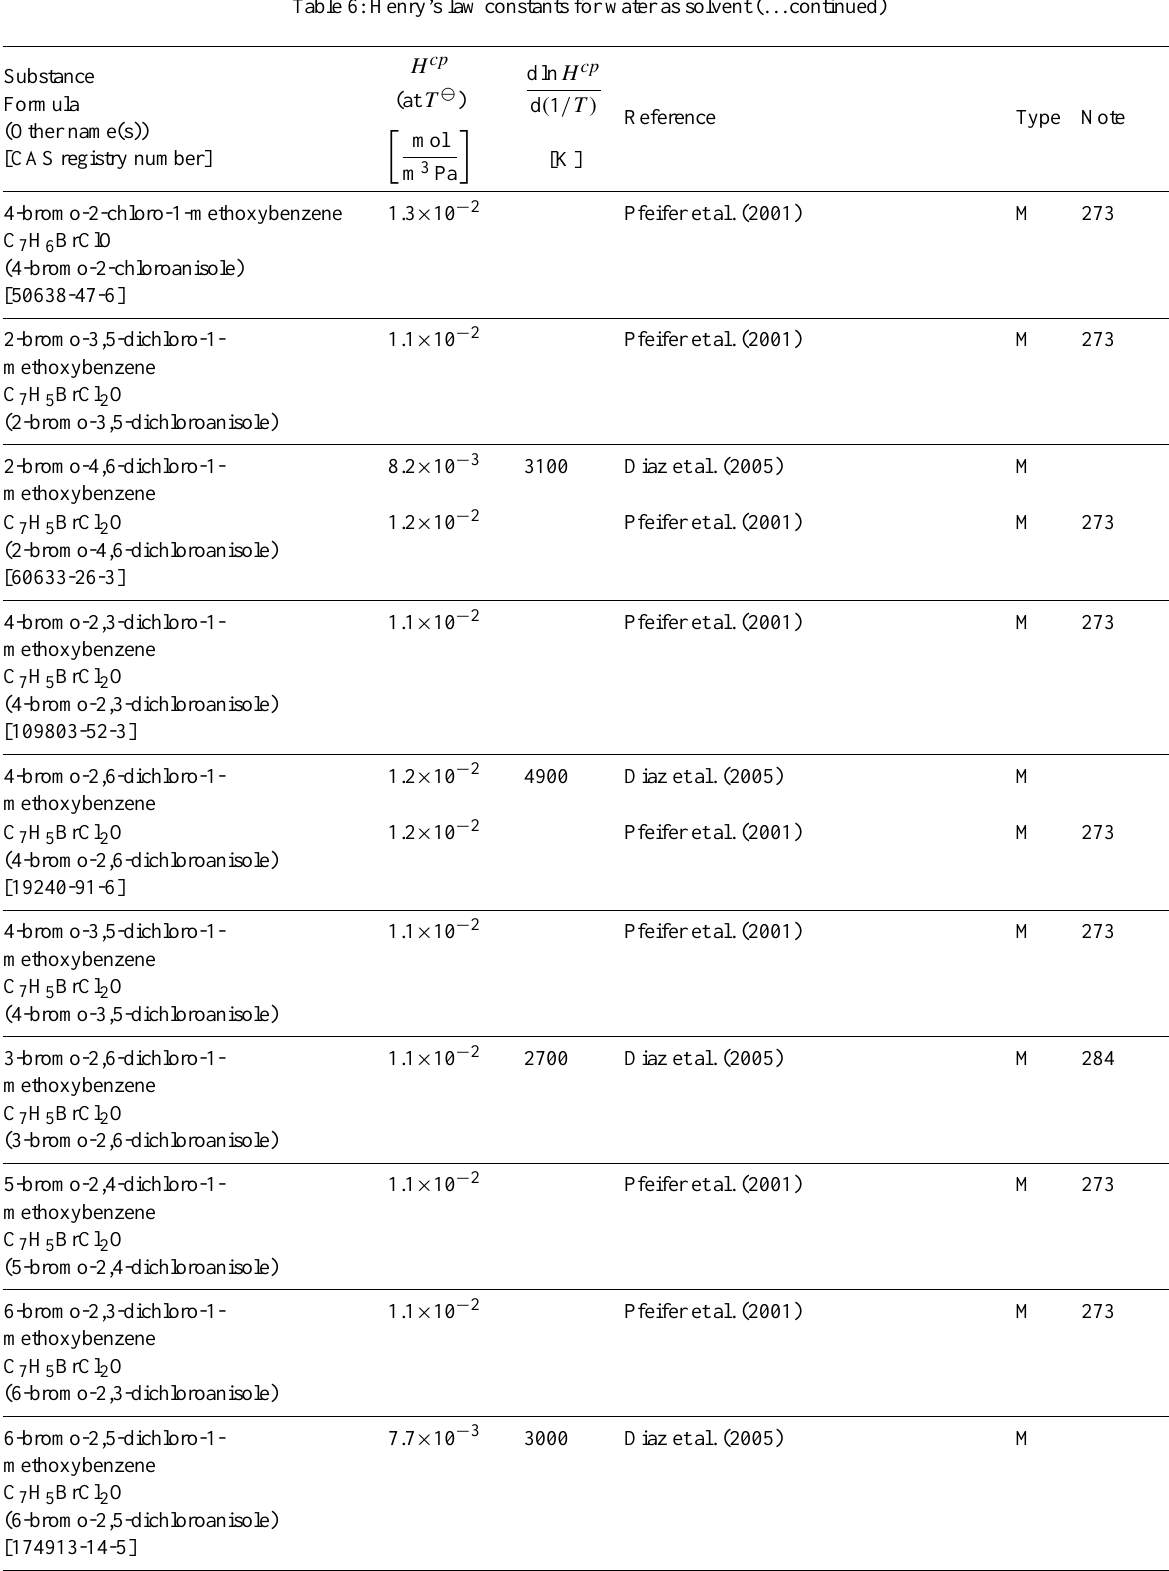
Table 6: Henry’s law constants for water as solvent